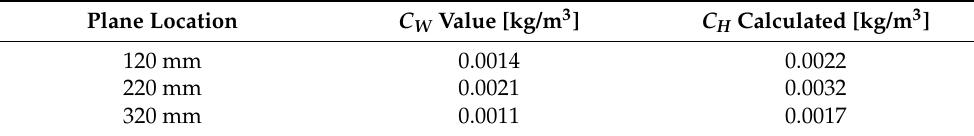
Table 3. Alternative method for calibrating the CFD-DEM simulation. Plane